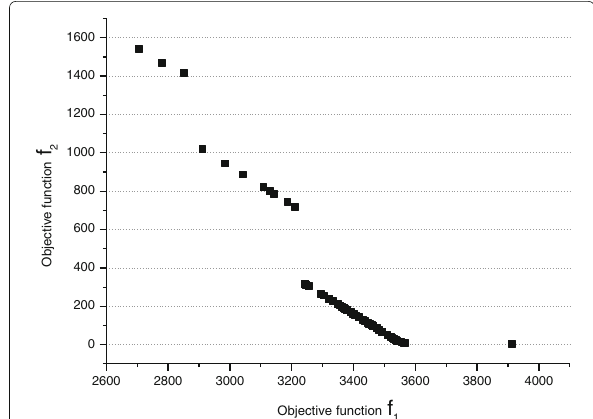
Fig. 10 Pareto optimal front of the 10ch150.tsp instance when